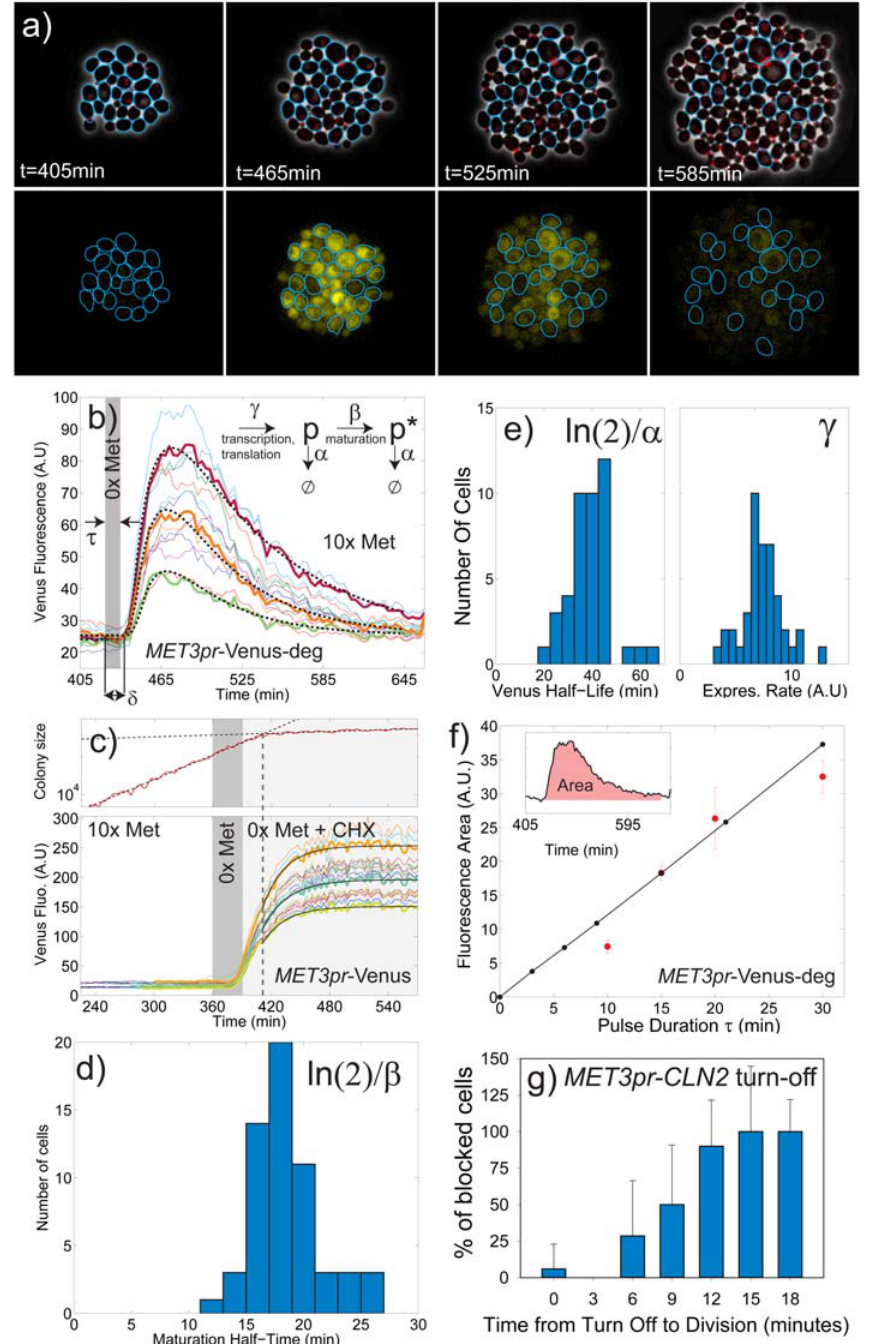
Figure 2. Transient induction of the MET3 promoter; a) Phase contrast, and fluorescence images of MET3pr-Venus-deg cells that were shifted to media lacking Met (0x Met) for 15 minutes at T=420 min. Blue contours indicate cells whose mean fluorescence is monitored in (b). Top images show the phase contrast overlaid with the MYO1-mCherry budneck marker. Bottom images show the Venus fluorescence in the yellow channel. b) Quantification of mean cellular fluorescence as a function of time after media switch (indicated as grey shade). Each color curve represents a single (mother) cell. Several representative fits of the bold curves to the model (inset, see text) are shown as dashed lines. Inset: protein expression model used to analyze the fluorescence signal (see suppl. model for details). c) Measurement of Venus maturation time in cells carrying stable MET3pr- Venus; Cycloheximide (2 m g/ml) is added to the 0xMet media 30 minutes after MET3pr induction (gray shade). An abrupt cessation of growth ensues 21 min later as defined by the intersection of the two exponential fits (dashed) to the colony growth size (red curve, in square pixel units) in the top panel. Bottom: Colored curves show the kinetics of single cell fluorescence. Solid black lines are representative exponential fits to determine the maturation rate b. d) Histogram of the maturation half-time , T b . =ln(2)/ b measured by fitting individual cells as in (c) : , T b . =ln(2)/ b =18.5 + / 2 0.4 min, COV=0.16. e) Single cell histograms of Venus-deg protein degradation half-time , T a . =ln(2)/ a and expression rate c ; , T a . =ln(2)/ a =39.2 + / 2 1.4 min, COV=0.23, , c . =7.3 + / 2 0.3, COV=0.25. f) Integrated mean fluorescence as function of pulse duration (red dots); black dots are predicted using the model, the mean model parameters, and the imposed pulse duration. g) Fraction of blocked cells in a strain that requires CLN2 expression from the MET3pr after division for cell cycle progression, as a function of the time between the switch to 10xMet media and division. This sets a stringent bound on the turnoff time of MET3pr; see text. doi:10.1371/journal.pone.0001468.g002 PLoS ONE |